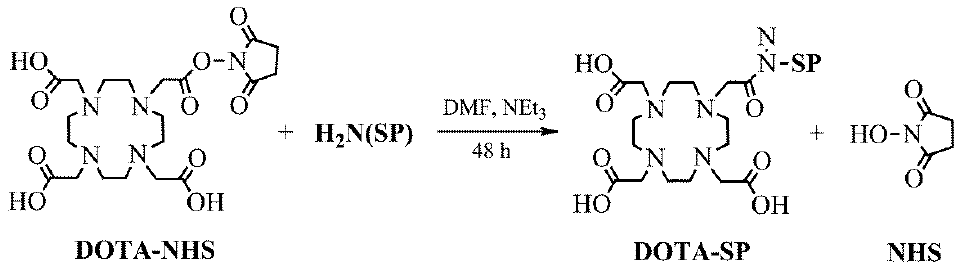
Scheme 1. Coupling reaction of CN-BFCA with SP Scheme 2. Coupling reaction of DOTA-NHS with SP fragments.